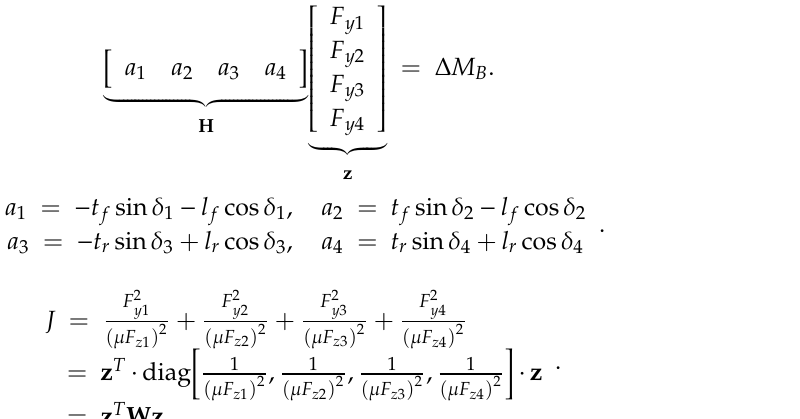
Figure 2 [21]. The objective function of WPCA is defined in Equation (9). The objective function, Equation (9), is used to minimize the lateral tire forces satisfying Equation